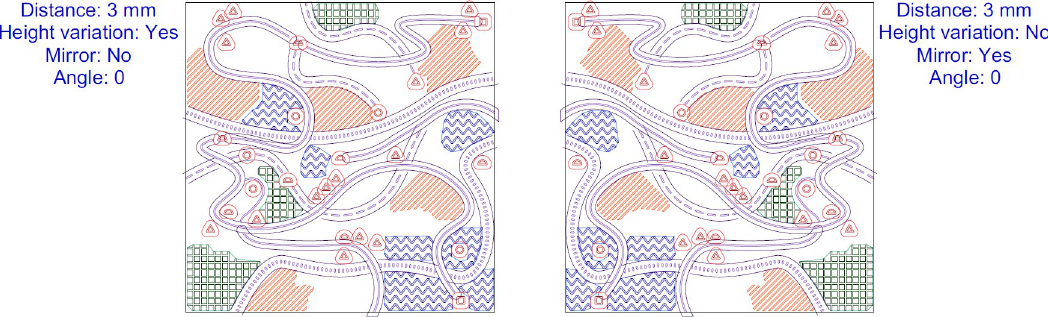
Fig 6. A pair of vector drawings used for geometric calculations. The applied 3 mm offsets are